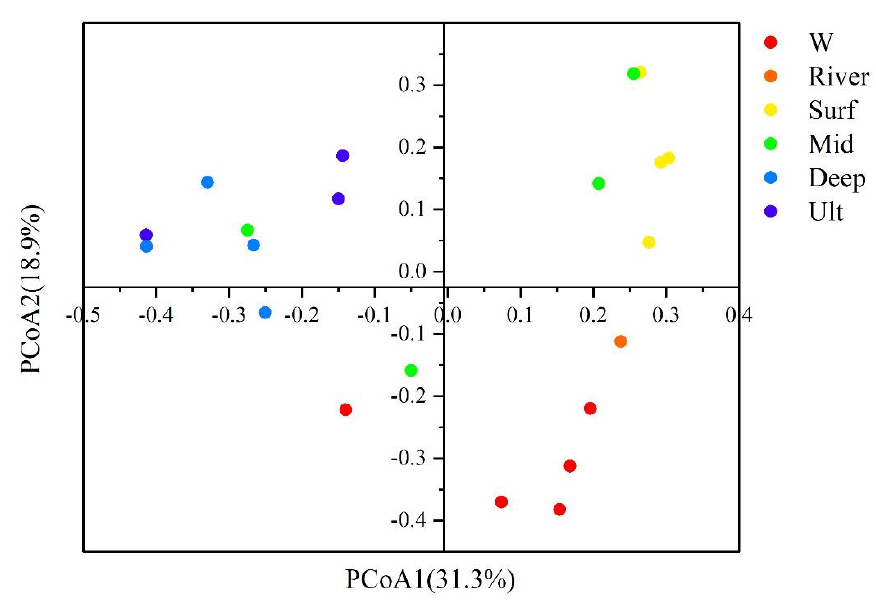
Figure 3. PCoA plot of β -diversity of bacterial communities.